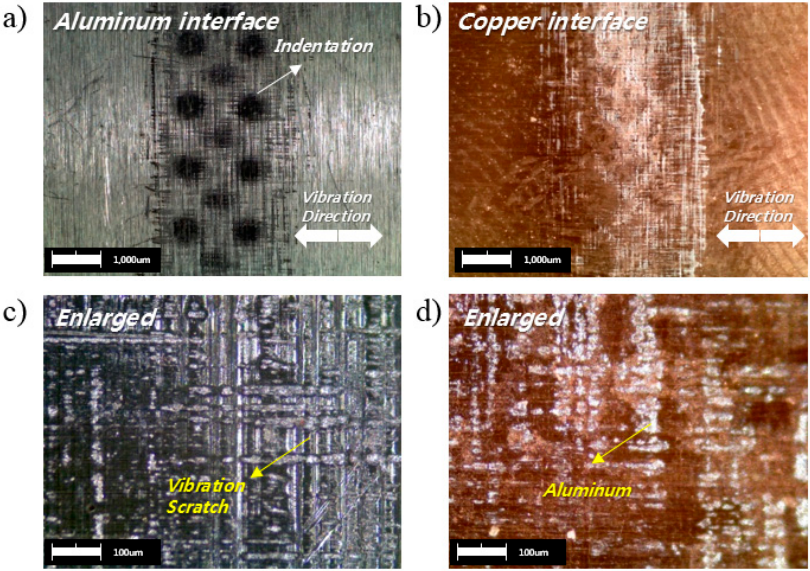
Figure 17. Comparison of the interface shape of Al and Cu: ( a ) aluminum interface, ( b ) copper interface, ( c ) enlarged aluminum interface, and ( d ) enlarged copper interface.